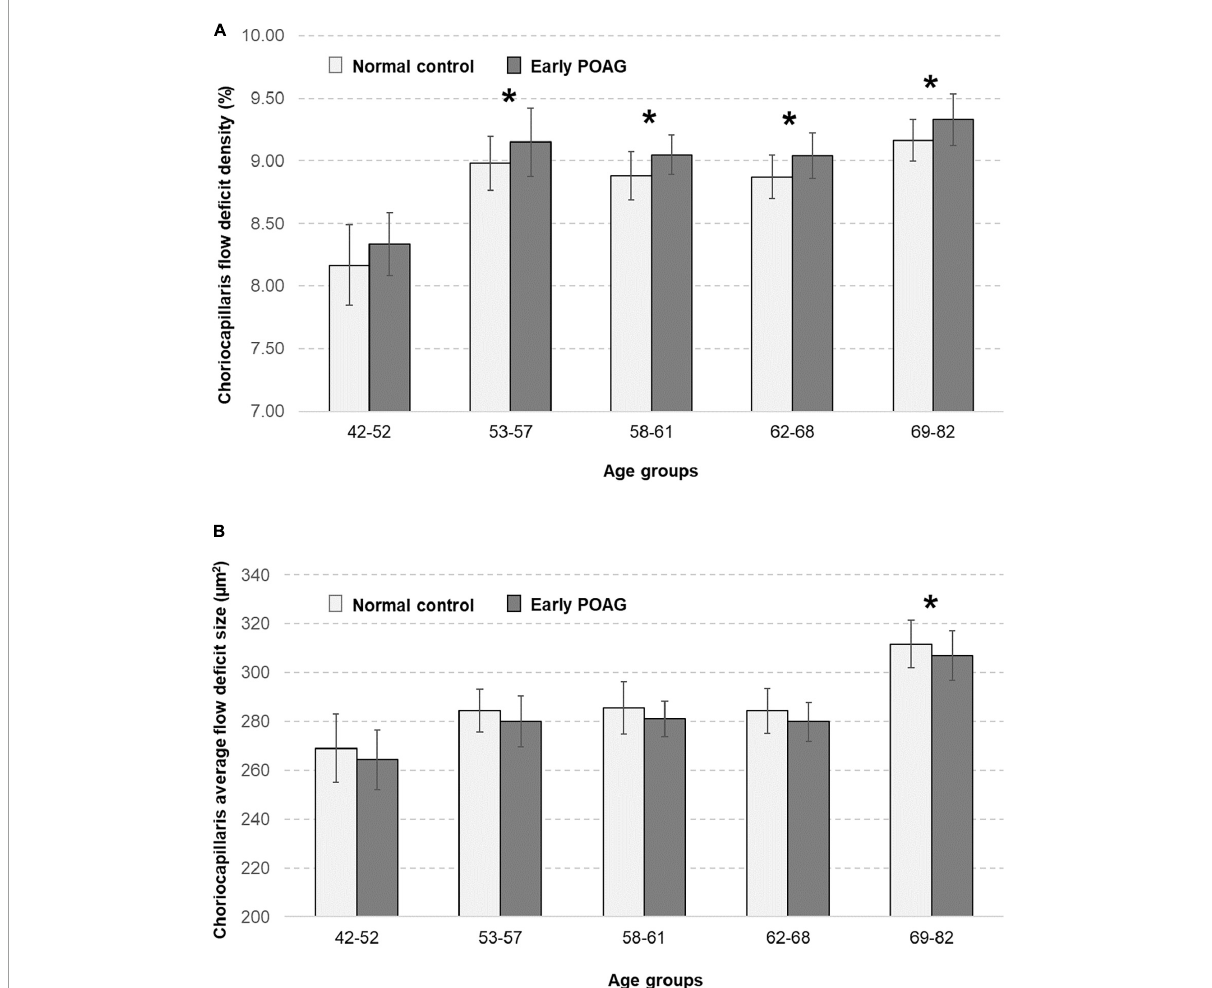
FIGURE3 Relationship between the choriocapillaris (A) flow deficit density (%) and (B) average flow deficit size ( µ m 2 ) in normal controls (light grey bars) and patients with early primary open angle glaucoma (POAG; dark grey bars), stratified by age groups. Choriocapillaris flow deficit density was evidently higher in those aged 53 years and above (all P ≤ 0.024) whereas the average flow deficit size was significantly larger in those aged 69 years and above ( P = 0.006) in both normal and glaucoma patients. There were no differences in the choriocapillaris characteristics between normal and glaucoma patients. Asterisks mark significant differences in reference to the youngest age group according to multivariable linear regression analysis with generalized estimating equations (GEE) adjusted for diabetes, hypertension, intraocular pressure, axial length, and signal strength of